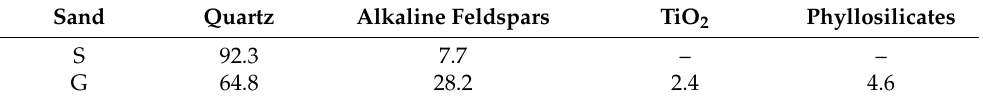
Table 4. Quantitative mineralogical composition of siliceous (S) and granite (G) sand (wt%). Sand Quartz Alkaline Feldspars TiO 2 Phyllosilicates S 92.3 7.7 – – G 64.8 28.2 4.6 The particle size distribution used was the same in the siliceous and granite sands to